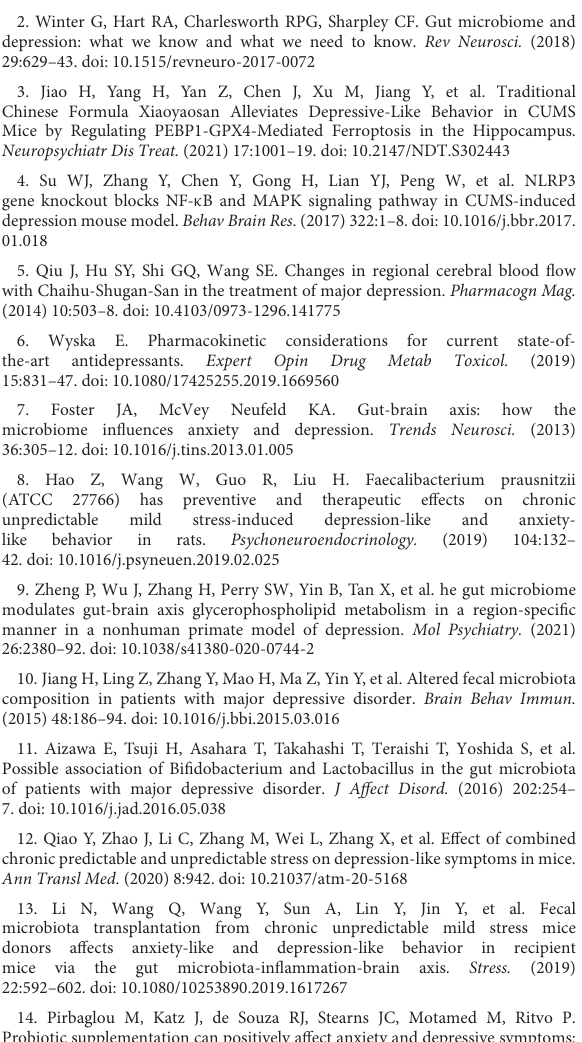
SUPPLEMENTARYFIGURE1 Effects of probiotics treatment on alpha-diversity induced by CUMS.